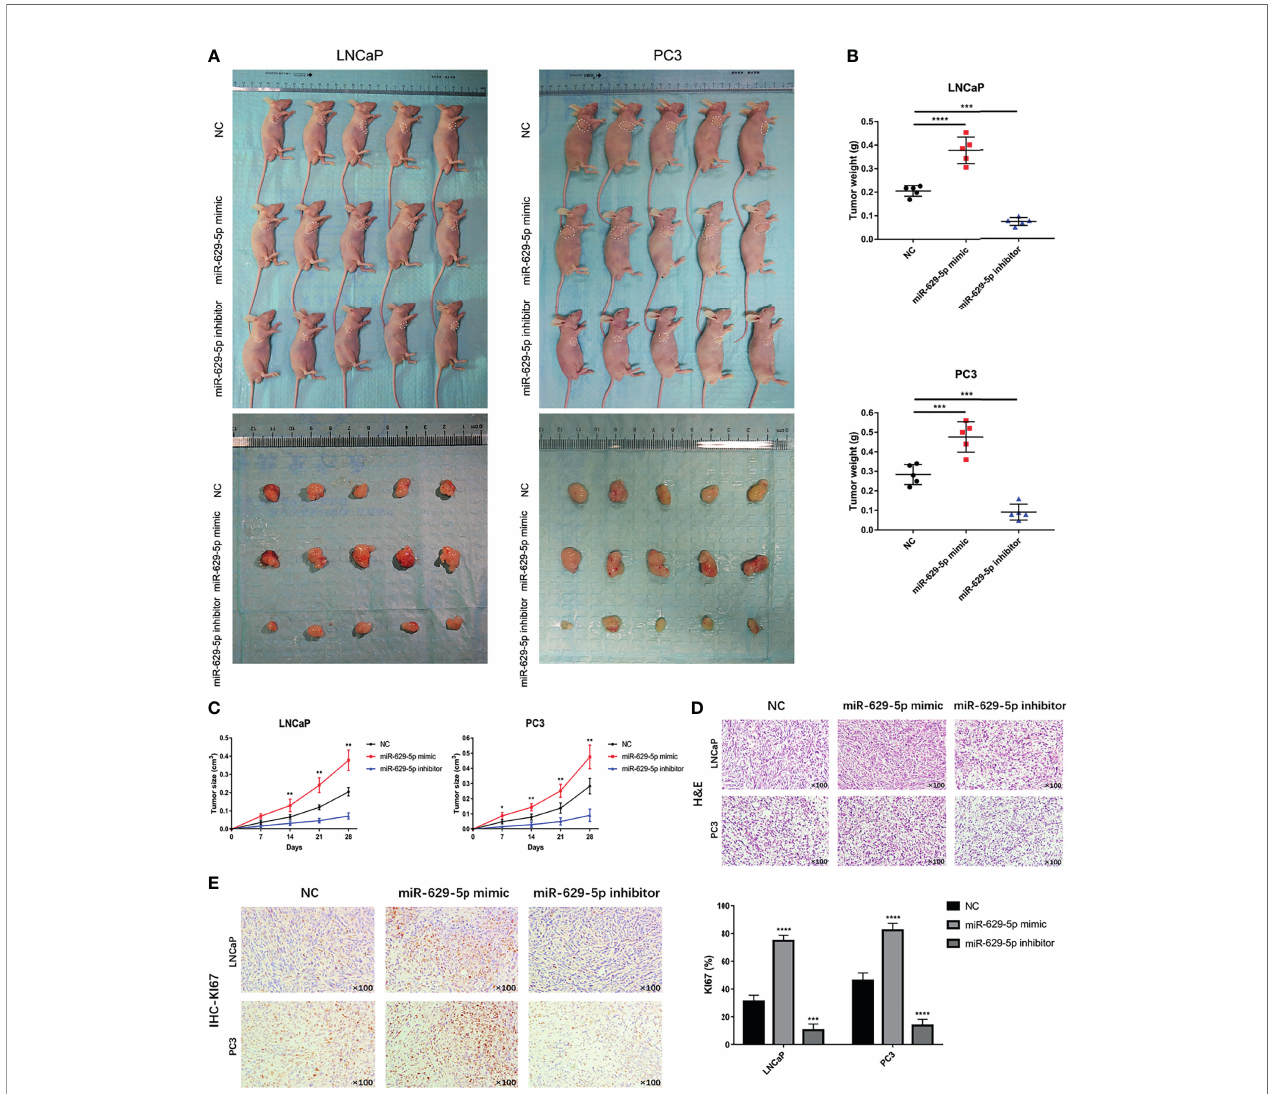
FIGURE 3 | MiR-629-5p promotes tumor growth in vivo . (A) The subcutaneous xenograft tumor model in nude mice was established, and the representative appearance of tumor mass resected from each group of mice. (B) Final tumor weights were measured at autopsy on day 28 after subcutaneous injection stable transfected PCa cells. (C) The tumor growth curves were measured with a calliper at the indicated days after cell injecting. (D) The xenograft tumor tissues were stained with H&E. (E) KI67 IHC staining was performed in xenograft tumor tissues to assess tumor proliferation. Magni fi cation, ×100. The data were presented as means ± SD from three biological replicates. *P < 0.05; **P < 0.01; ***P < 0.001; ****P < 0.0001; Student ’ s